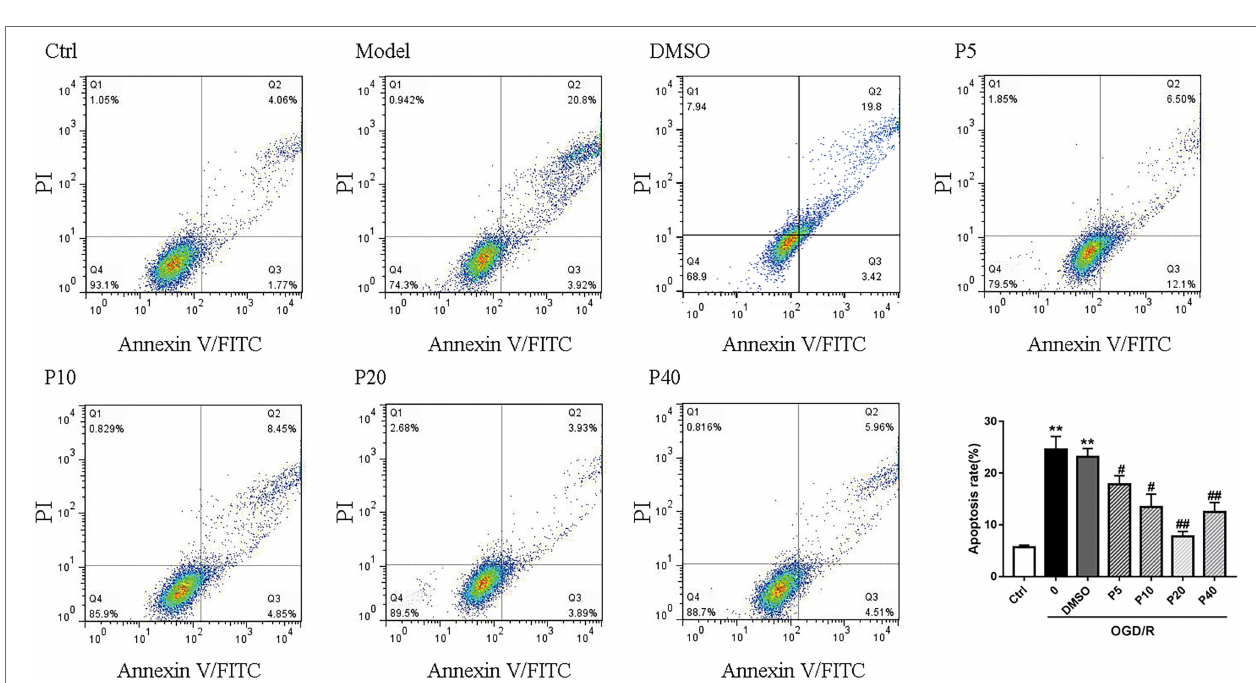
FIGURE 1 | Effects of propofol on ROS contents during OGD/R in H9c2 cells. DMSO and propofol adopted during the entire ischemia/reperfusion phase. The ctrl group was defined as 100%. (A) Effects of propofol on OGD/R induced intracellular ROS contents increase in H9c2 cells. (B) Representative DCF fluorescent images, ×100. The results were shown as mean ± SD from three independent experiments. * p < 0.05, ** p < 0.01, *** p < 0.001 versus control, # p < 0.05, ## p < 0.01, ### p < 0.001 versus OGD/R treated group without